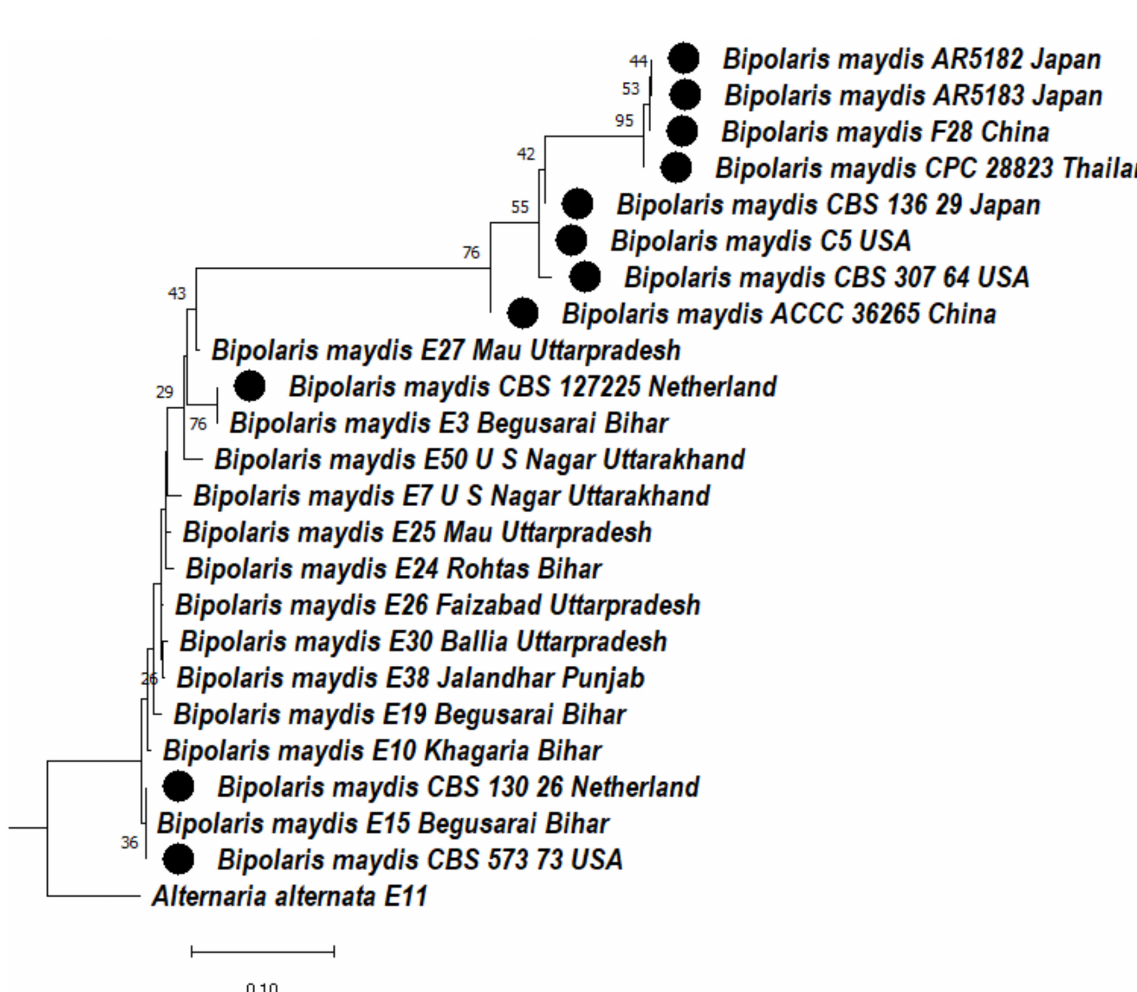
Figure 4. Dendrogram constructed from maximum likelihood method based on combined internal transcribed spacer (ITS) and large Subunit gene regions (LSU) and glyceraldehyde-3-phosphate dehydrogenase (GAPDH). Sequenced data of the Bipolaris maydis isolates were inferred with Raxml based on GTR + Gamma model. Numerical value presented in the node indicates bootstrap value with a 1000 non-parametric bootstrap replicate analysis. The symbol • denotes as ‘ ex-type ’ closely related species sequences obtained from GenBank. Alternaria alternata used as an